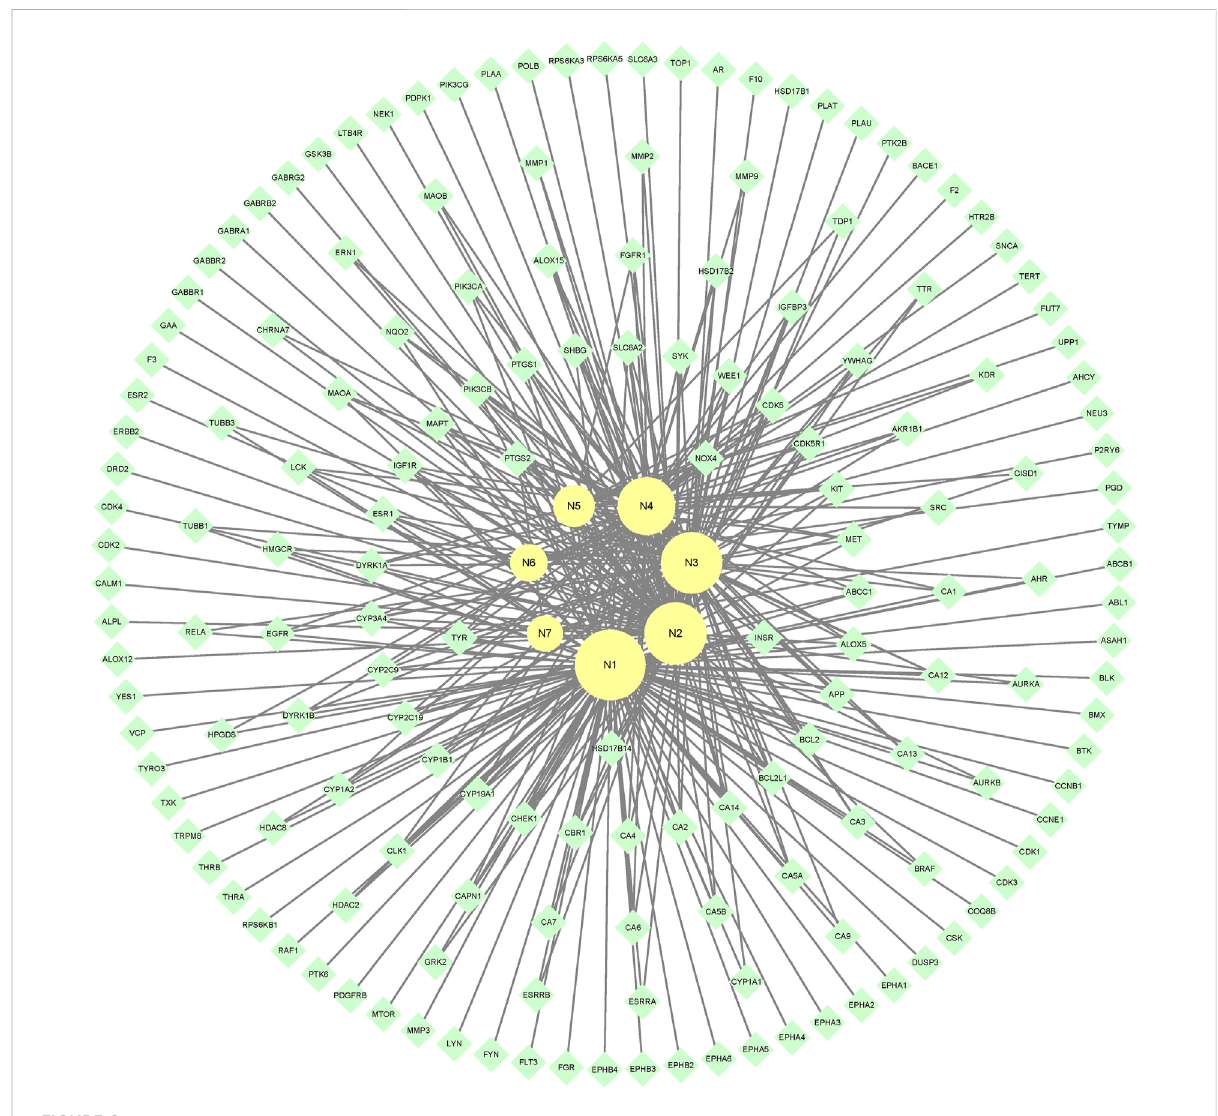
FIGURE 8 The metabolite-target network of mulberroside A